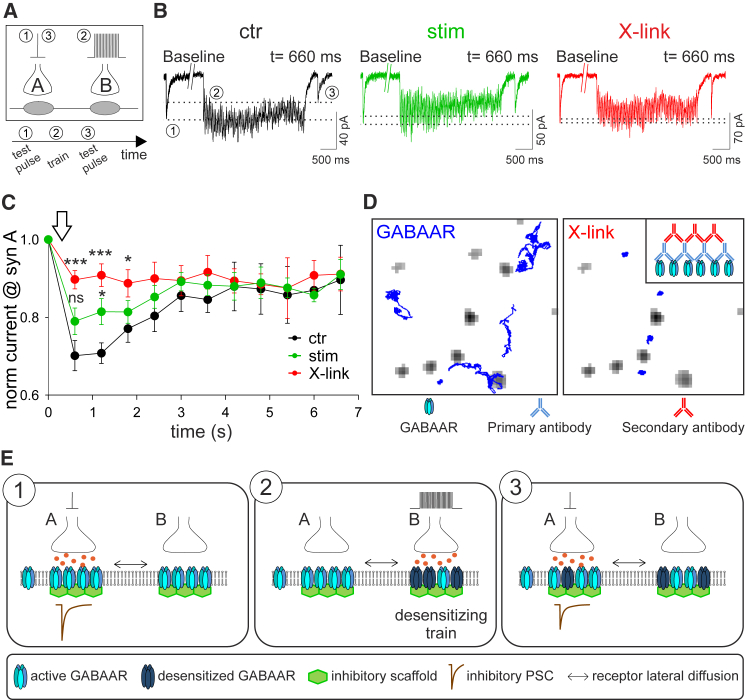
Inter-synaptic GABAAR Diffusion Shapes Inhibitory Synaptic Currents(A) Schematic of the GABA uncaging protocol. (1) A single UV laser pulse (0.5 ms, 0.1 mW) is applied at “synapse A” to record a baseline uIPSC. (2) A UV laser train pulse (4 s at 16 Hz) induces synaptic GABAAR desensitization at “synapse B.” (3) A UV laser pulse at “synapse A” monitors the modulation of uIPSC after the desensitizing train at “synapse B.”(B) Representative traces of uncaging currents recorded in the control (black), during LiGluK2 activation (green), and upon the X-link protocol (red), before (1) and 660 ms after (3) the UV laser train pulse, as described in (A).(C) Normalized recovery of uIPSC amplitude induced at “synapse A” after the delivery of the UV laser train pulse at “synapse B” (arrow) in the control (black), LiGluK2 (green), and X-link (red). At 660 ms: ctr = 0.71 ± 0.03, n = 12; 11 neurons in 5 cultures; stim = 0.82 ± 0.04, n = 12; 6 neurons in 4 cultures; X-link = 0.91 ± 0.03, n = 14; 9 neurons in 4 cultures; p < 0.05 ctr versus stim, p < 0.001 ctr versus X-link, Mann-Whitney U-test. Data are represented as means ± SEM.(D) Reconstructed trajectories of GABAARs (blue) in control (left) and upon GABAAR X-link (right). Inhibitory synapses are in gray. Inset: schematic of the X-link protocol.(E) Model for the modulation of uIPSCs by inter-synaptic lateral diffusion of desensitized GABAARs. Upon sustained inhibitory synaptic activity, the amplitude of synaptic responses at individual synapses is reduced by intruder desensitized GABAARs from neighboring synapses. Impeding GABAAR lateral diffusion prevents such modulation of inhibitory synaptic transmission.